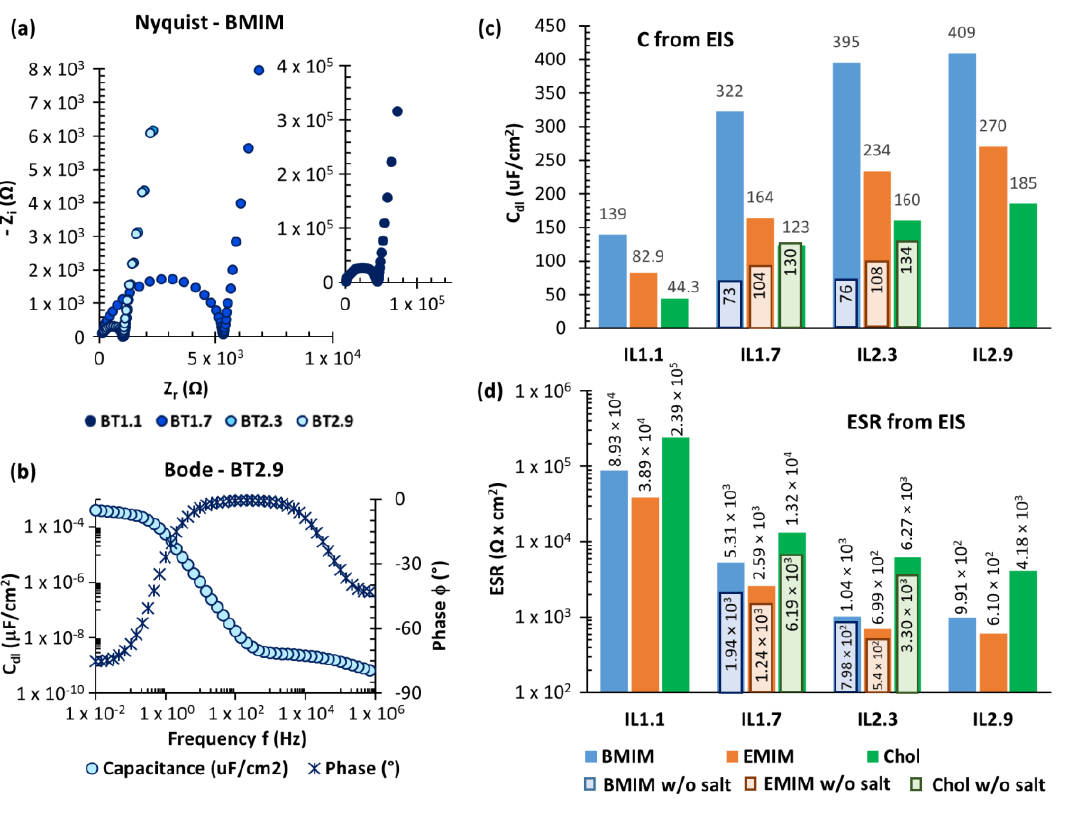
Figure 4. ( a ) Nyquist plots of the samples with the BMIM(TFSI) ionic liquid; ( b ) Bode plot of the sample BT2.9, showing the double layer capacitance and the current phase according to the frequency of the applied AC; ( c , d ) capacitance and equivalent series resistance (ESR) (respectively) of all tested supercapacitors, calculated from Electrochemical impedance spectroscopy (EIS)